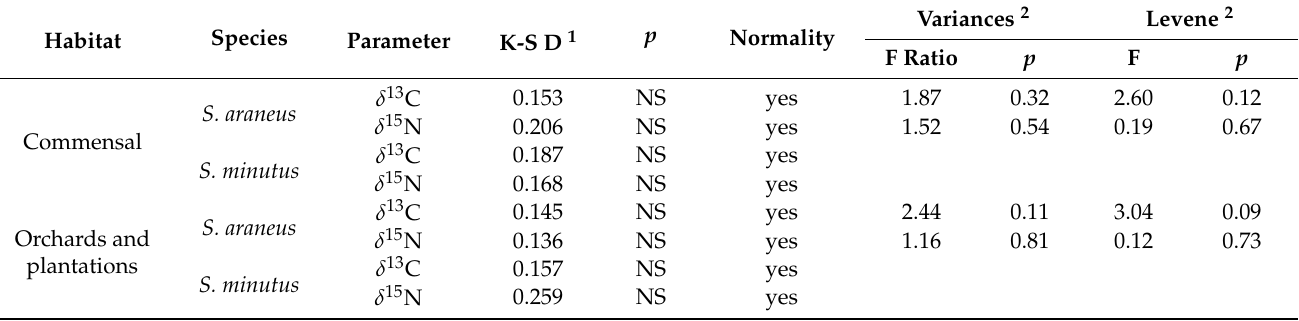
Table A3. Test of the datasets of δ 15 N and δ 13 C values in S. araneus and S. minutus hair for ANOVA assumptions and homogeneity of